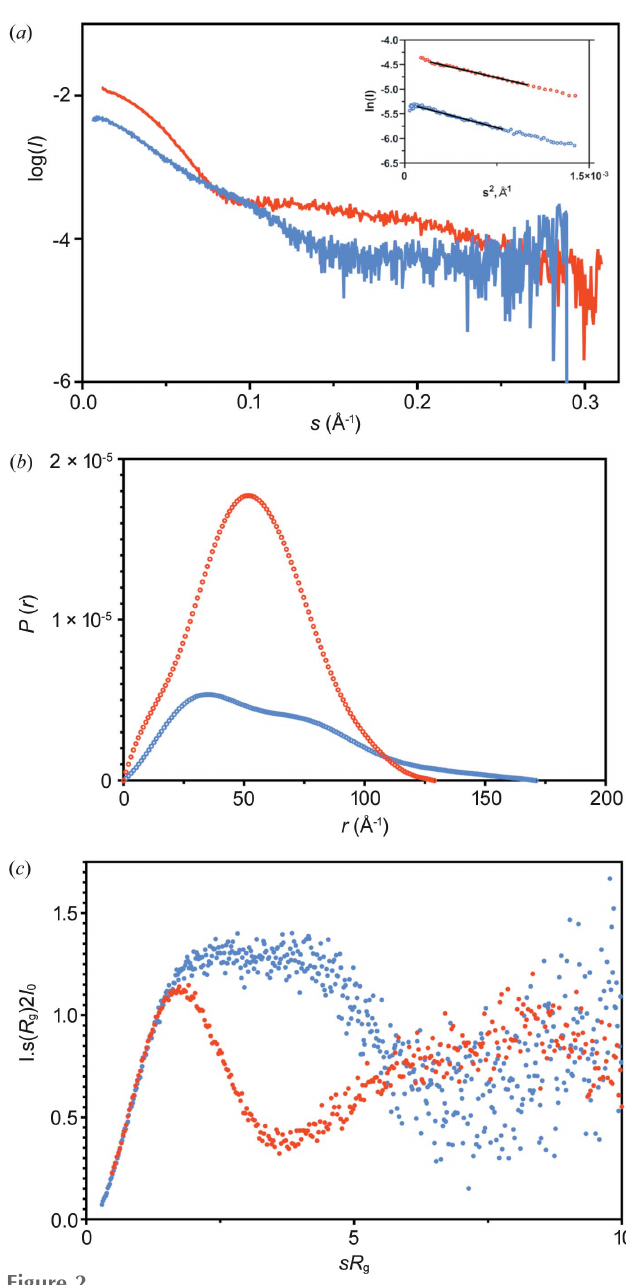
Figure 2 SEC-SAXS results for the EptA:DDM complex and EptA:DPC complex. ( a ) I ( s ) versus s , as log–linear plots with the inset showing the Guinier fits (black line) laid on the experimental data (open symbols). ( b ) Profiles for the distance distribution function, P ( r ), in arbitrary units versus r in a˚ngstro¨ms for the data shown in ( a ), normalized for ease of comparison. ( c ) Dimensionless Kratky plots for the data in ( a